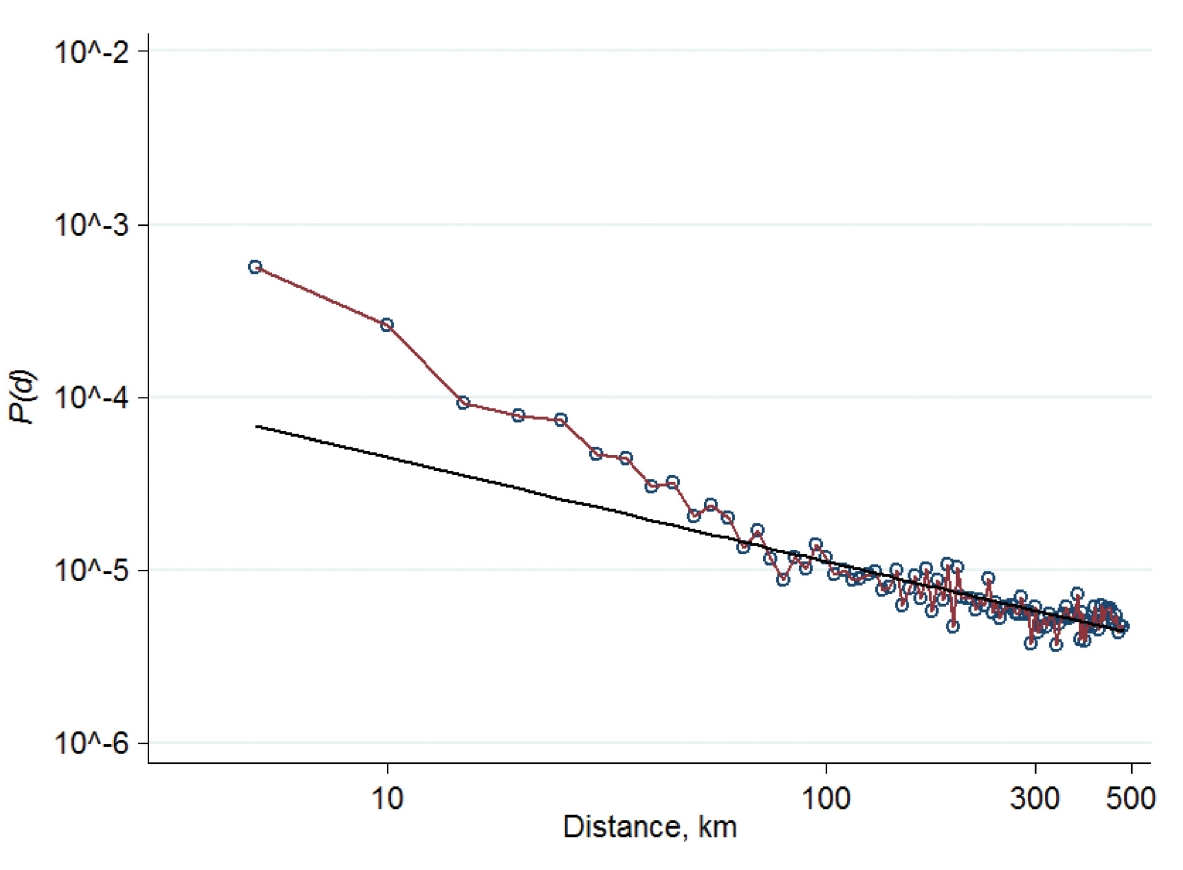
Fig 2. The probability of links as function of distance. Probability P ( d ) is plotted as function of distance on a log-log scale. The straight line depicts a power-law d -0.6 .